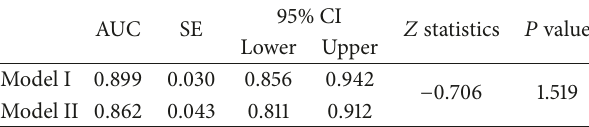
Table 4: Comparison of the ROC areas of the APACHE II and SAPS II scores and their ability to predict the 28-day survival rate in patients with AECOPD requiring emergency critical